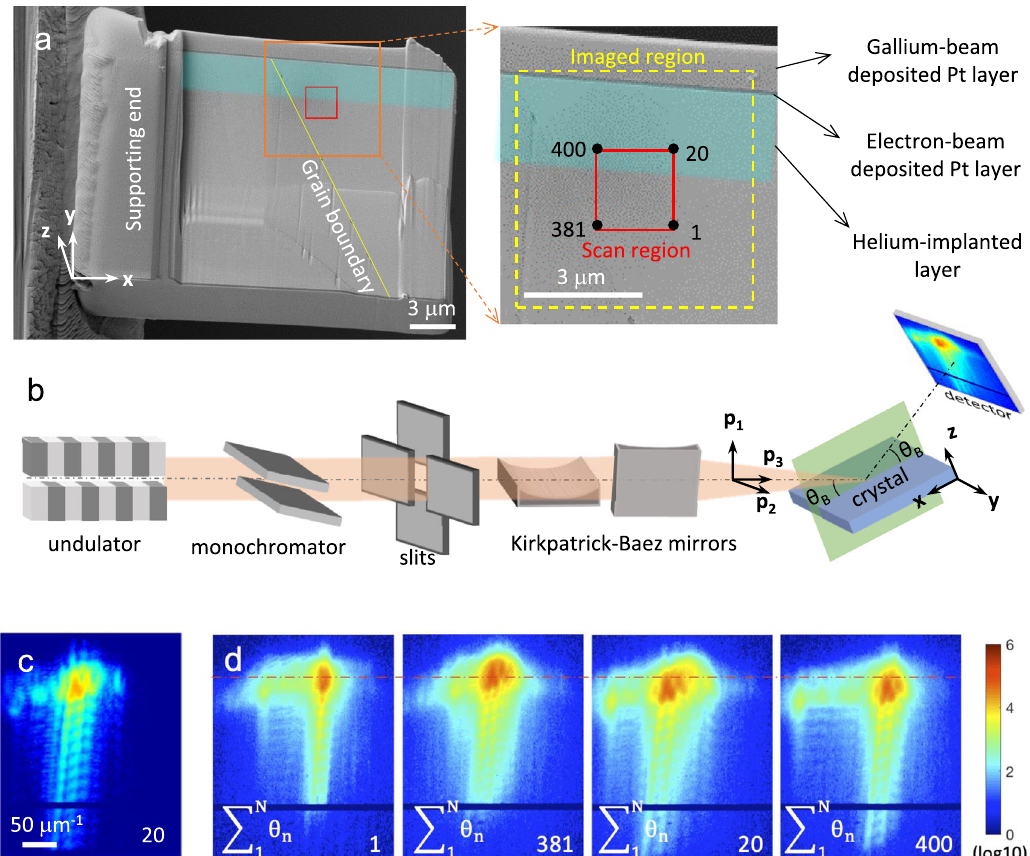
Fig. 1 X-ray diffraction microscopy of the He-implanted tungsten foil. a Scanning electron microscopy images of the tungsten foil sample. The platinum protection layers, helium-implanted layer and the grain boundary are indicated. The red rectangle shows the extreme probe positions used during the ptychography raster scan (noted as ‘ 1 ’ , ‘ 20 ’ , ‘ 381 ’ and ‘ 400 ’ , in agreement with their order within the full scan), while the dashed yellow rectangle corresponds to the area fi nally imaged with BP. b Experimental setup for Bragg ptychography at the synchrotron beamline, detailing the main components used to condition the beam and detect the diffraction signal. The sample frame ( x , y , z ) and the probe frame ( p 1 , p 2 , p 3 ) are de fi ned. c Example of a diffraction pattern, obtained at the maximum of the Bragg peak, at position 20. d A series of four diffraction intensity patterns integrated overall angles along the rocking curve, plotted for the four extreme positions of the raster scan. For ( c , d ) the used logarithmic colour scale is